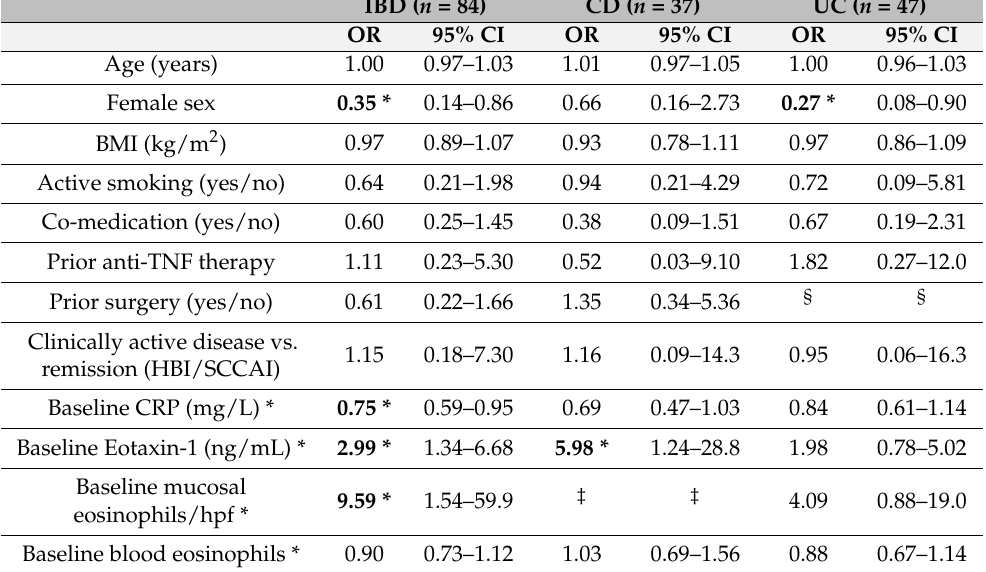
Table 2. Univariable logistic regression analysis of predictors of clinical response or remission to vedolizumab induction therapy at week 14 in patients with IBD included in the discovery